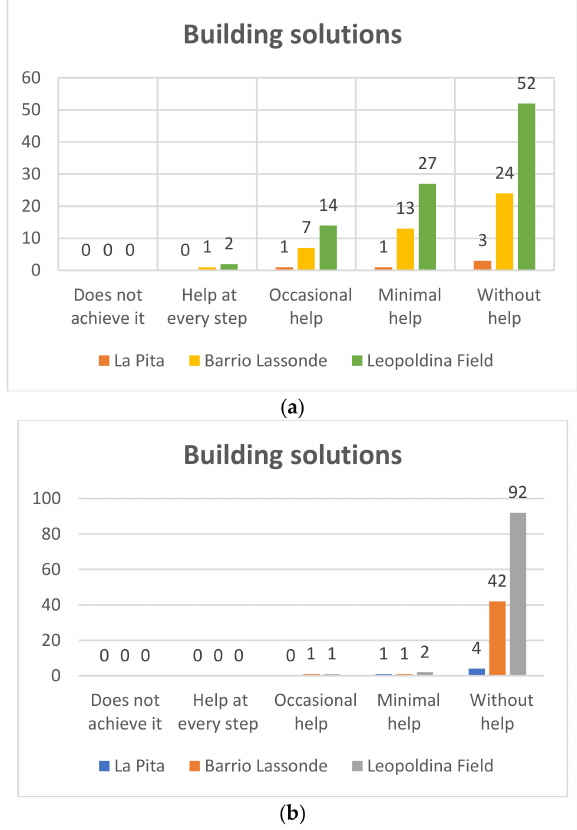
Figure 14. First grade building solutions: Pre-Test ( a ) and Post-Test ( b